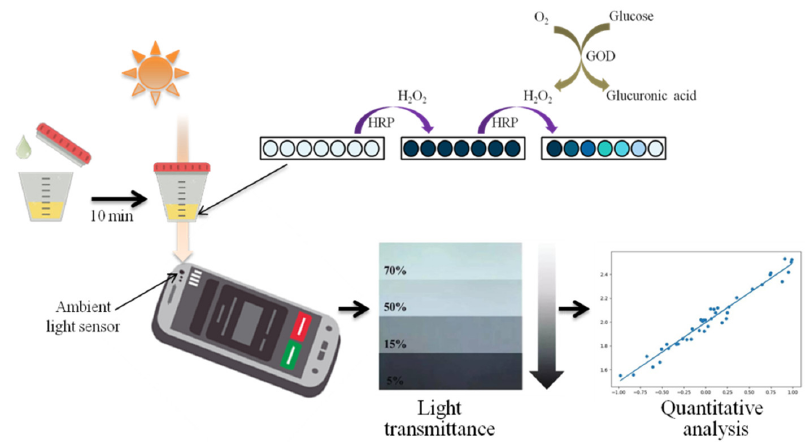
Figure 2. Illustration of the proposed analytical procedure.